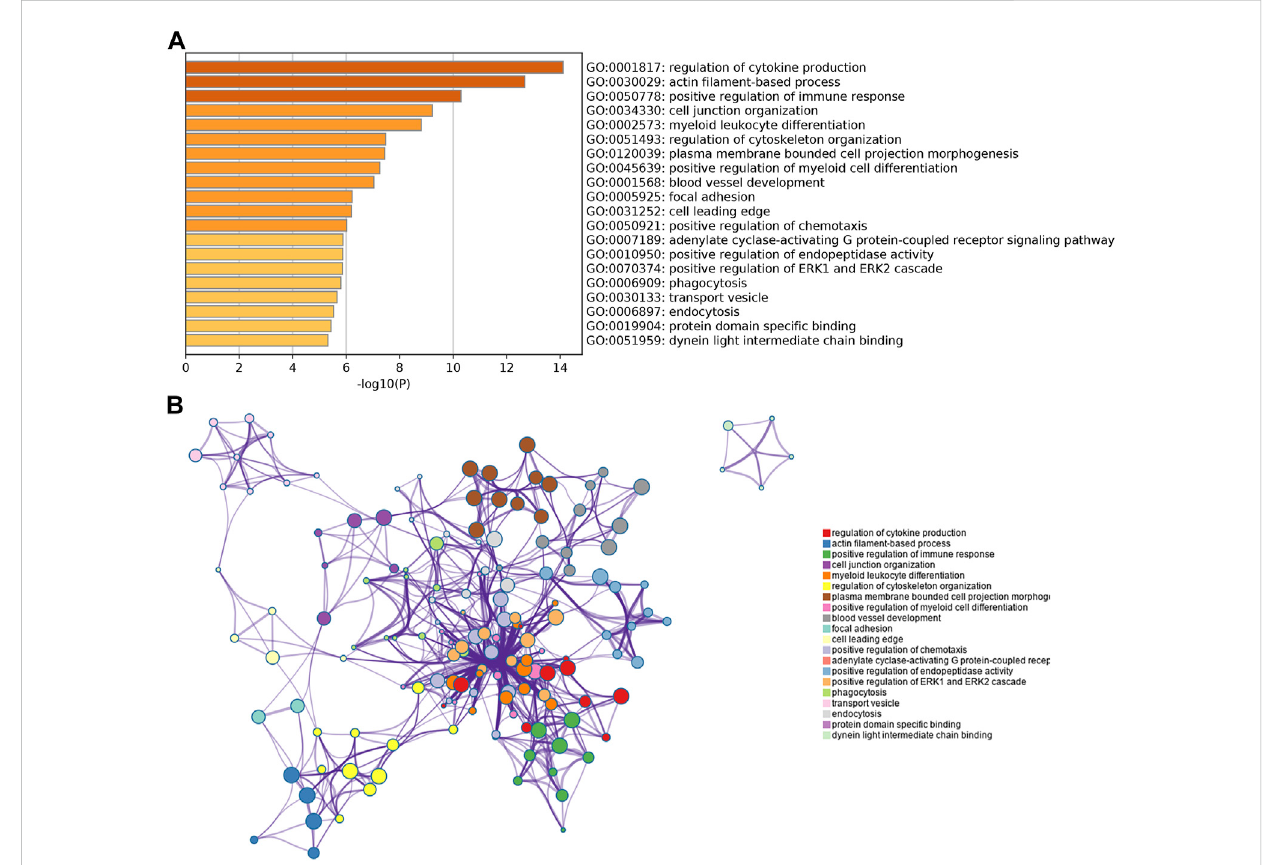
FIGURE 2 GO enrichment analysis of overlapping genes obtained from the intersection between DEGs and miRNA target genes. (A) Bar chart of the most highly enriched terms. (B) Network of the most highly enriched